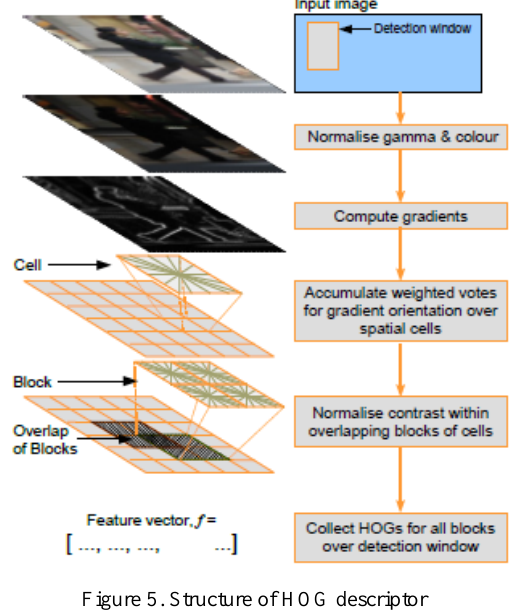
Figure 5. Structure of HOG descriptor (source: Dalal and Triggs,